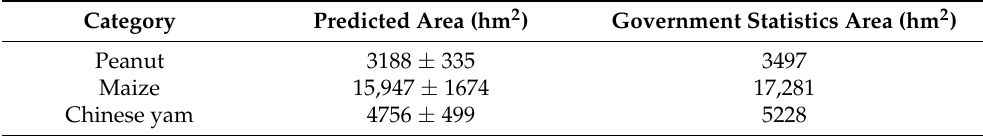
Table 8. Comparison of predicted area with statistical yearbook